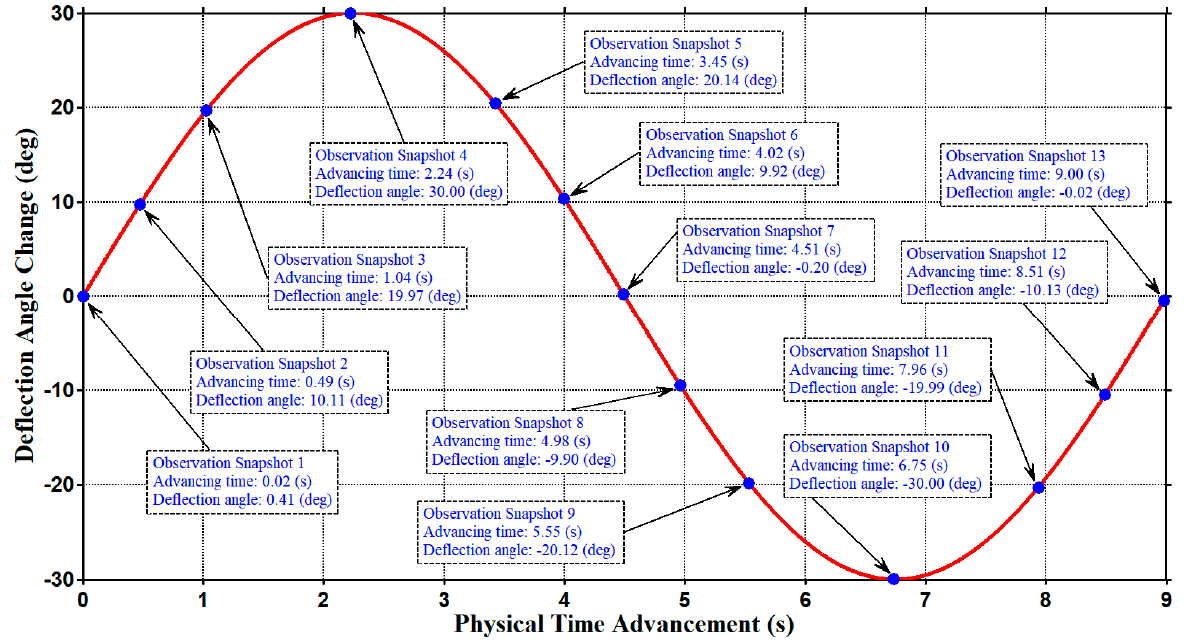
Figure 7. The relevance of the selected wake snapshots and the overall evolutionary advancement.